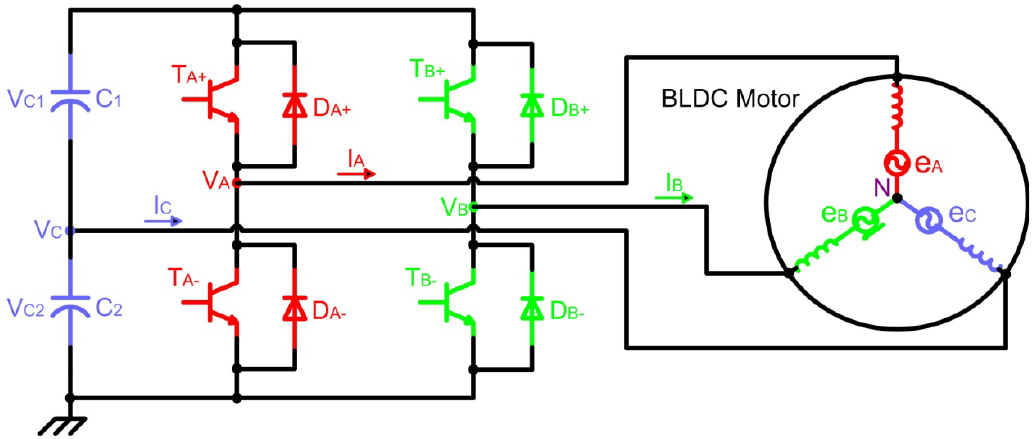
Figure 17. Four-switch converter for driving a three-phase BLDC motor